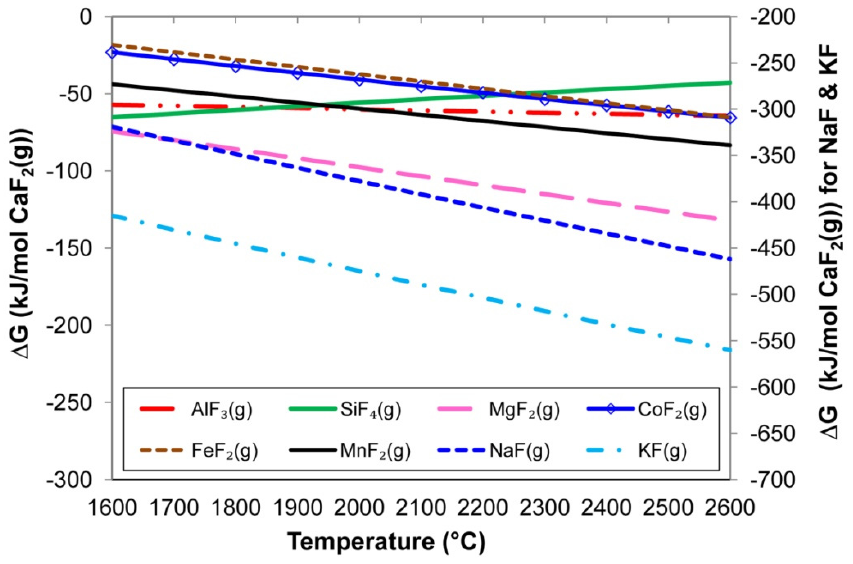
Figure 5. Gibbs free energy for metal oxide and CaF 2 gas reactions as calculated in FactSage 7.3 [31].